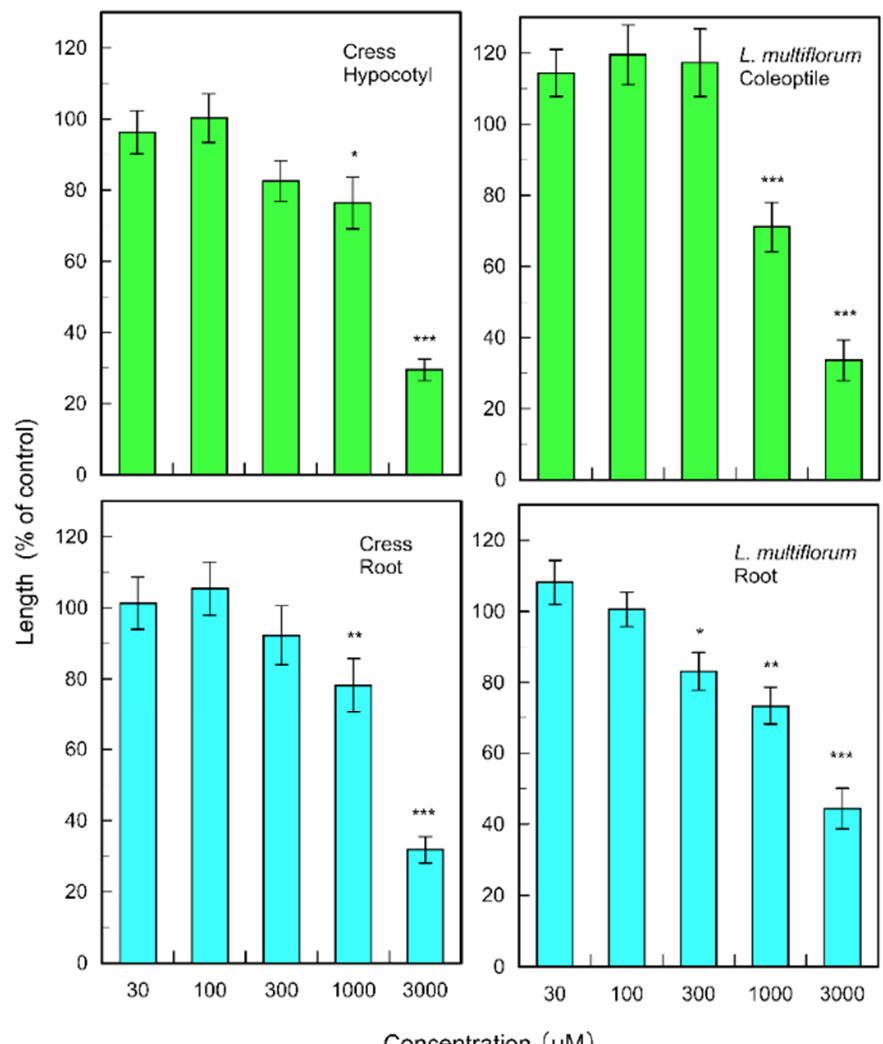
Figure 6. Effects of (+)-rhododendrol on root and hypocotyl/coleoptile growth of cress and L. multiflorum. Means ± SE from 2 independent experiments with 10 seedlings for each determination are shown. Asterisks indicate significant differences between control and treatment: *, p < 0.05, **, p < 0.01, ***, p < 0.001.